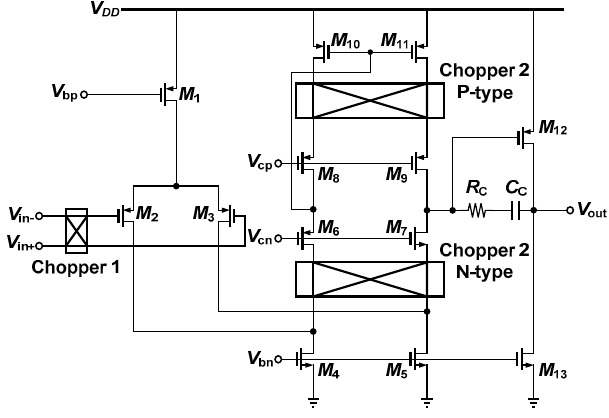
Figure 3. Chopper operational amplifier [9].